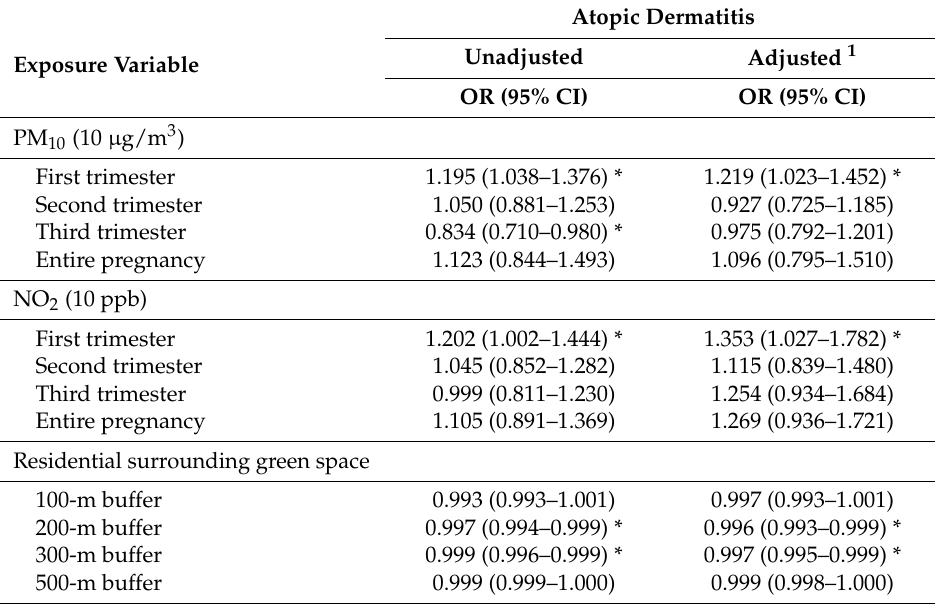
Table 3. Risk of atopic dermatitis in 6-month-old children with prenatal exposure to ambient PM 10 /NO 2 and green space in their area of residence.